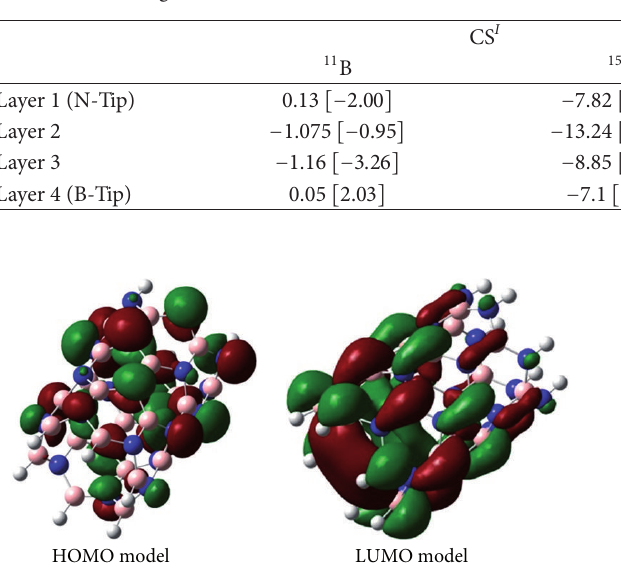
T 4: e average deviations of (b) model (and (c) model in brackets) for CS